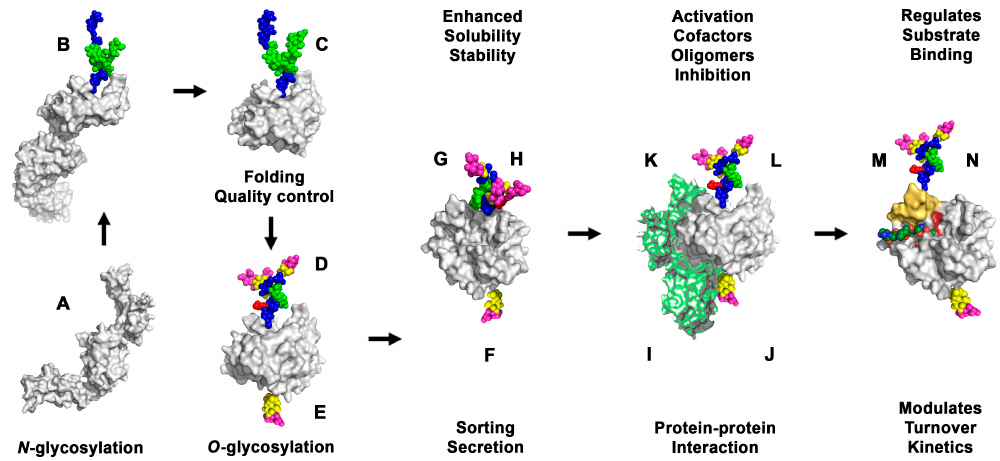
Figure 6. Effects of glycosylation on human proteases. After protein synthesis ( A ) unfolded proteases enter the endoplasmic reticulum (ER), N -glycans are linked ( B ); which supports folding ( C ); The N -glycans are trimmed and extended, accompanied by quality control ( D ); N -glycans are further modified and O -glycans are attached in the Golgi ( E ); Sorting leads to membrane anchoring or storage in secretory vesicles ( F ); After secretion, glycosylation prevents aggregation and unspecific binding ( G ); as well as proteolysis, which increases the stability and lifetime of proteases ( H ); Glycosylation regulates binding of: activators ( I ); cofactors ( J ) oligomer partners ( K ); inhibitors ( L ); and substrates ( M ); Eventually, glycosylation fine tunes turnover and kinetic parameters in enzymatic reactions ( N ) [183].